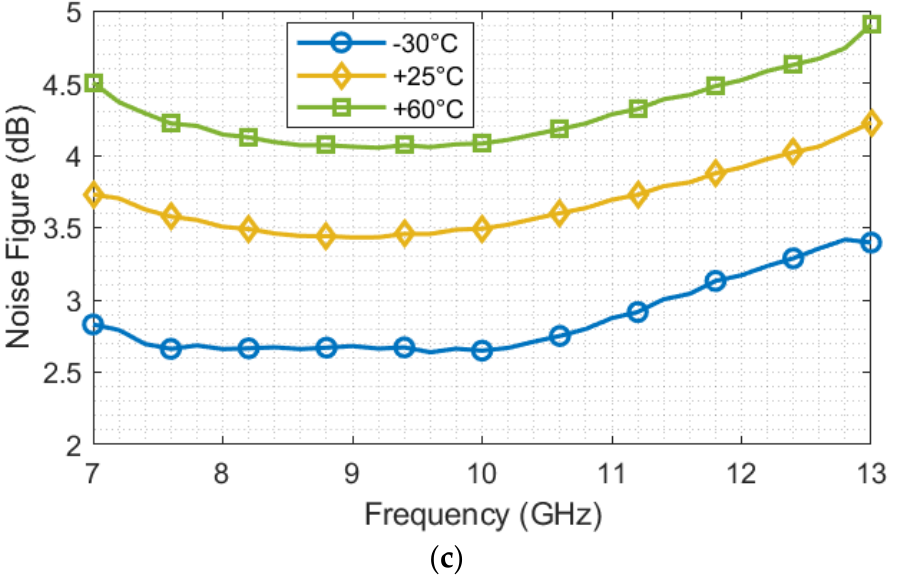
Figure 14. ( a ) Return loss at both ends of the RX chain. ( b ) Linear RX gain (S 21 ) over temperature. ( c ) Noise figure over temperature.